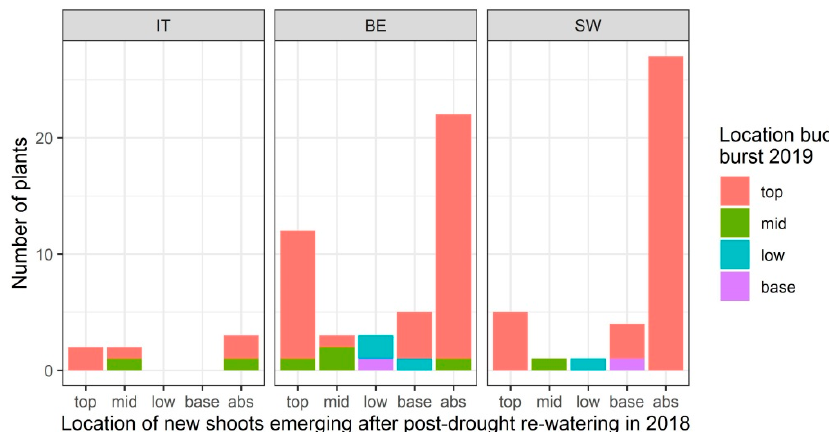
Figure 9. Presence / absence of new shoots with new leaves emerging after post-drought re-watering among the surviving plants of the treatment group, with location of the emerging new shoots on the plant, and relation with the location of the bud burst in the subsequent spring. Top: top part of the central shoot, mid: middle part of the central shoot, low: lower part of the central shoot, base: base stem, abs: absent. IT: Italian provenance, BE: Belgian provenance, SW: Swedish provenance.